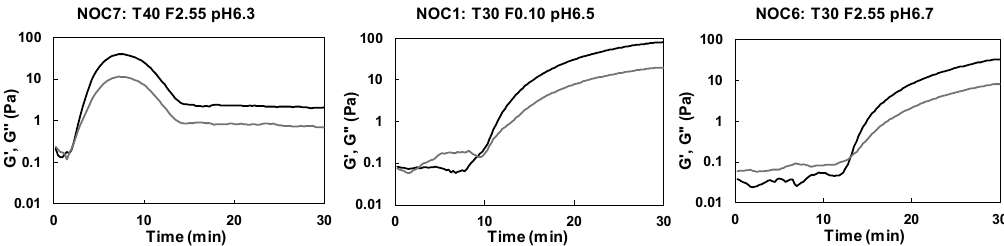
Figure 4. Time curing profiles of some of the evaluated milk renneting batches. Black and grey lines represent the elastic (G’) and viscous (G’’) modulus, respectively. See Table 1 for sample identification.